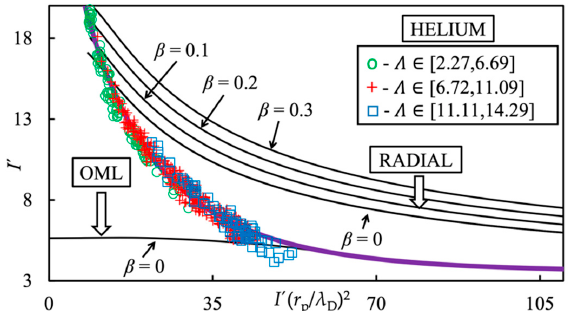
Figure 3. Helium plasma Sonin plot for the normalized probe potential y SP = 25. Experimental data for the helium plasma: green circles for 2.27 ≤ Λ ≤ 6.69, red crosses for 6.72 ≤ Λ ≤ 11.09 and blue squares for 11.11 ≤ Λ ≤ 14.29. In solid lines, the orbital and radial theoretical curves are shown. In purple bold line, the fitting curve for the experimental helium plasma Sonin plot points is shown.